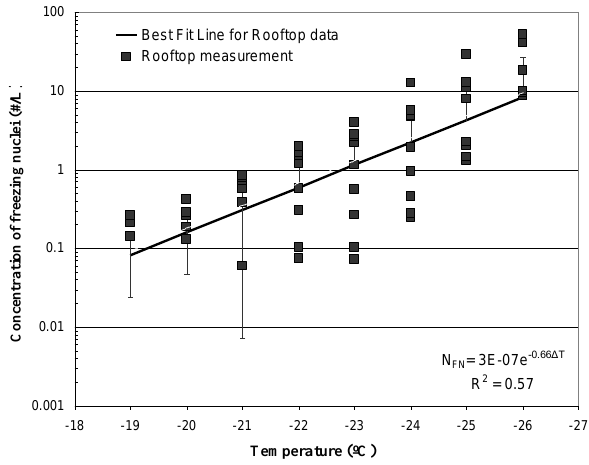
Fig. 10: The concentrations of FN in the air. The equation represents the best fit line to the rooftop data. Fig. 10. The concentrations of FN in the air. The equation repre- sents the best fit line to the rooftop data.